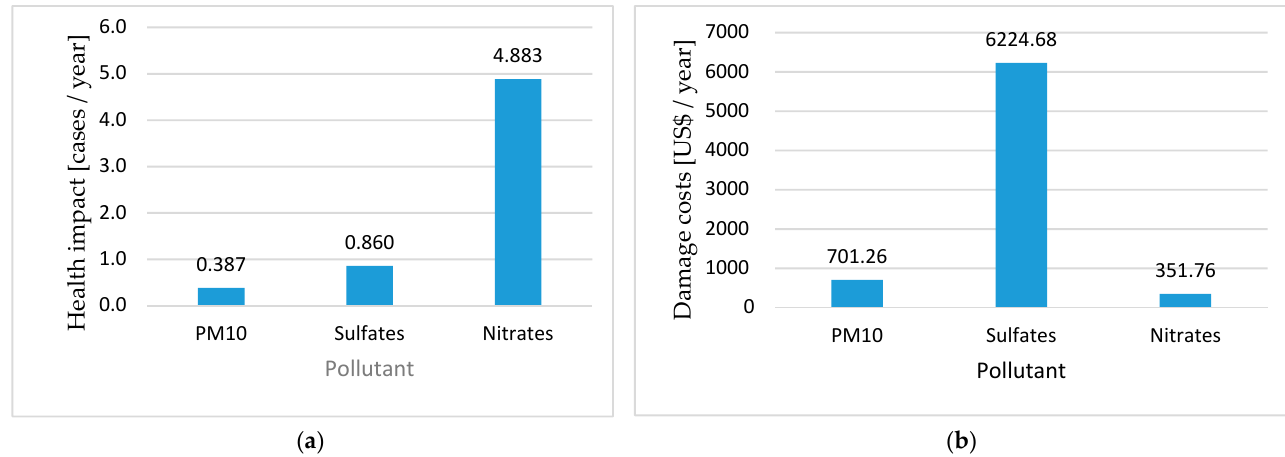
Figure 4. Increase in electricity production and demand from all power plants without a limit on CO 2 emission using MESSAGE code for the modeling period under study.